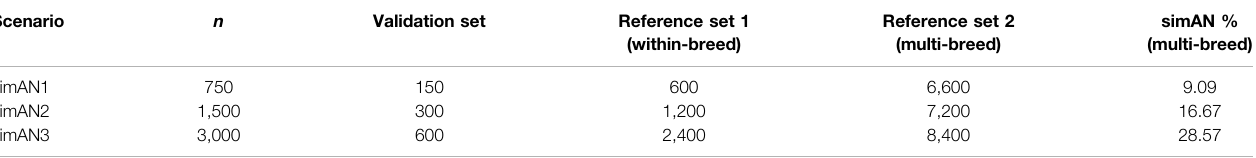
ThesizeofthesimulatedAnglerdataset(n),thenumberofsimulatedAnglerindividualsineachvalidationset(ValidationSet),thenumberofsimulatedAnglerindividualsineachreference setforwithin-breedprediction(ReferenceSet1),thenumberofsimulatedAnglerandsimulatedHolsteinFriesianindividualsinthereferencesetformulti-breedprediction(ReferenceSet2), and the proportion of simulated Angler individuals in the multi-breed reference set (simAN